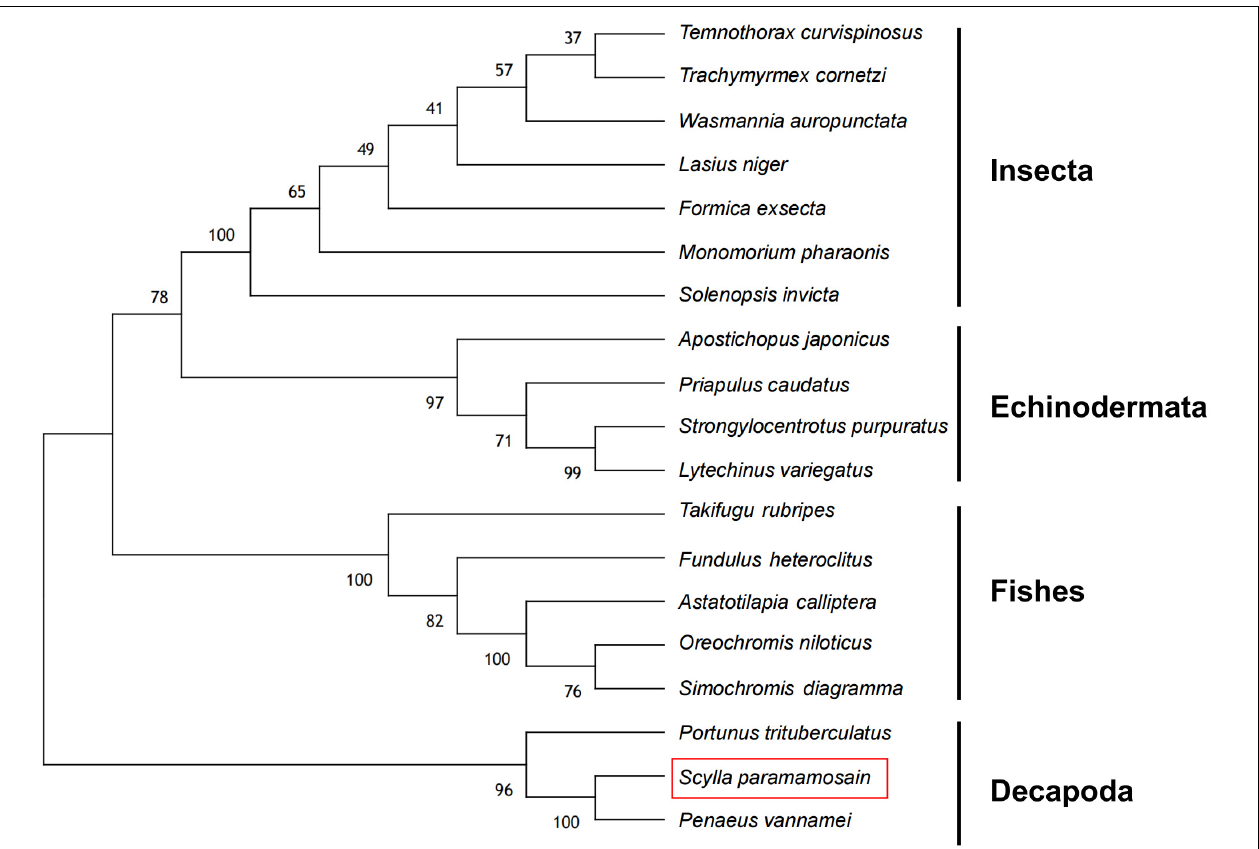
FIGURE 5 | Phylogenetic analysis of Sp-Pol protein (red rectangle) from S. paramamosain and homologous proteins from other species. The amino acid sequence and GenBank accession number of the proteins are provided in the Supplementary Material